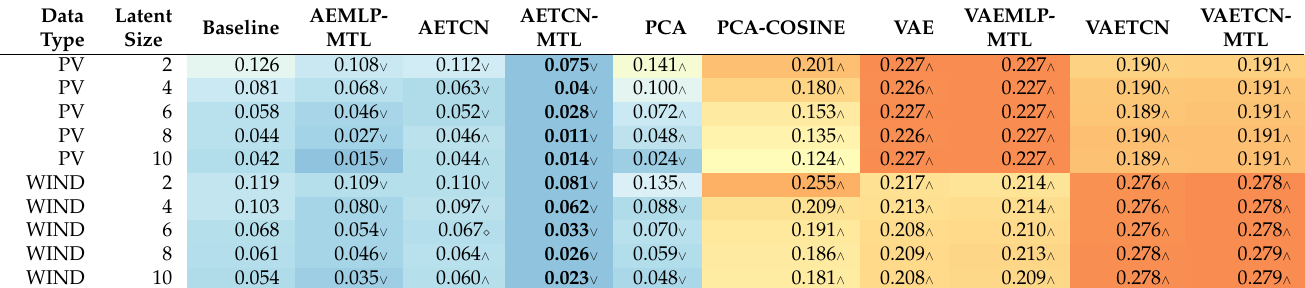
Table 6. Median nRMSE of the reconstruction error for all models and latent sizes for the autoencoder models (see Table 2), and the PCA-based models. AEMLP is the baseline and all models were tested to determine whether the reconstruction error is significantly better ( ∨ ), worse ( ∧ ), or not significantly different ( (cid:5) ) compared to the baseline. We test for a significant difference with Wilcoxon test ( α = 0.01). The colors denote the respective rank. Blue indicates a smaller (better) rank and red a higher (worse) rank. The best latent size and data type model is highlighted in